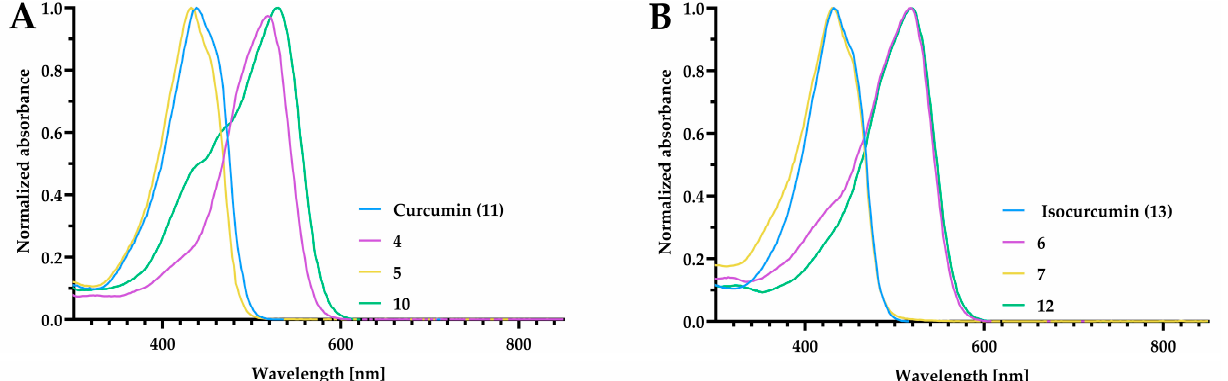
Figure 6. The normalized absorption spectra in DMSO of curcumin and its derivatives ( A ) and isocurcumin and its derivatives ( B ). The compounds were dissolved at the concentration of 10 µ M in DMSO, and DMSO was used as a blank. The spectra were recorded using a standard cuvette port for single sample absorbance with a Tecan Infinite M PLEX microplate